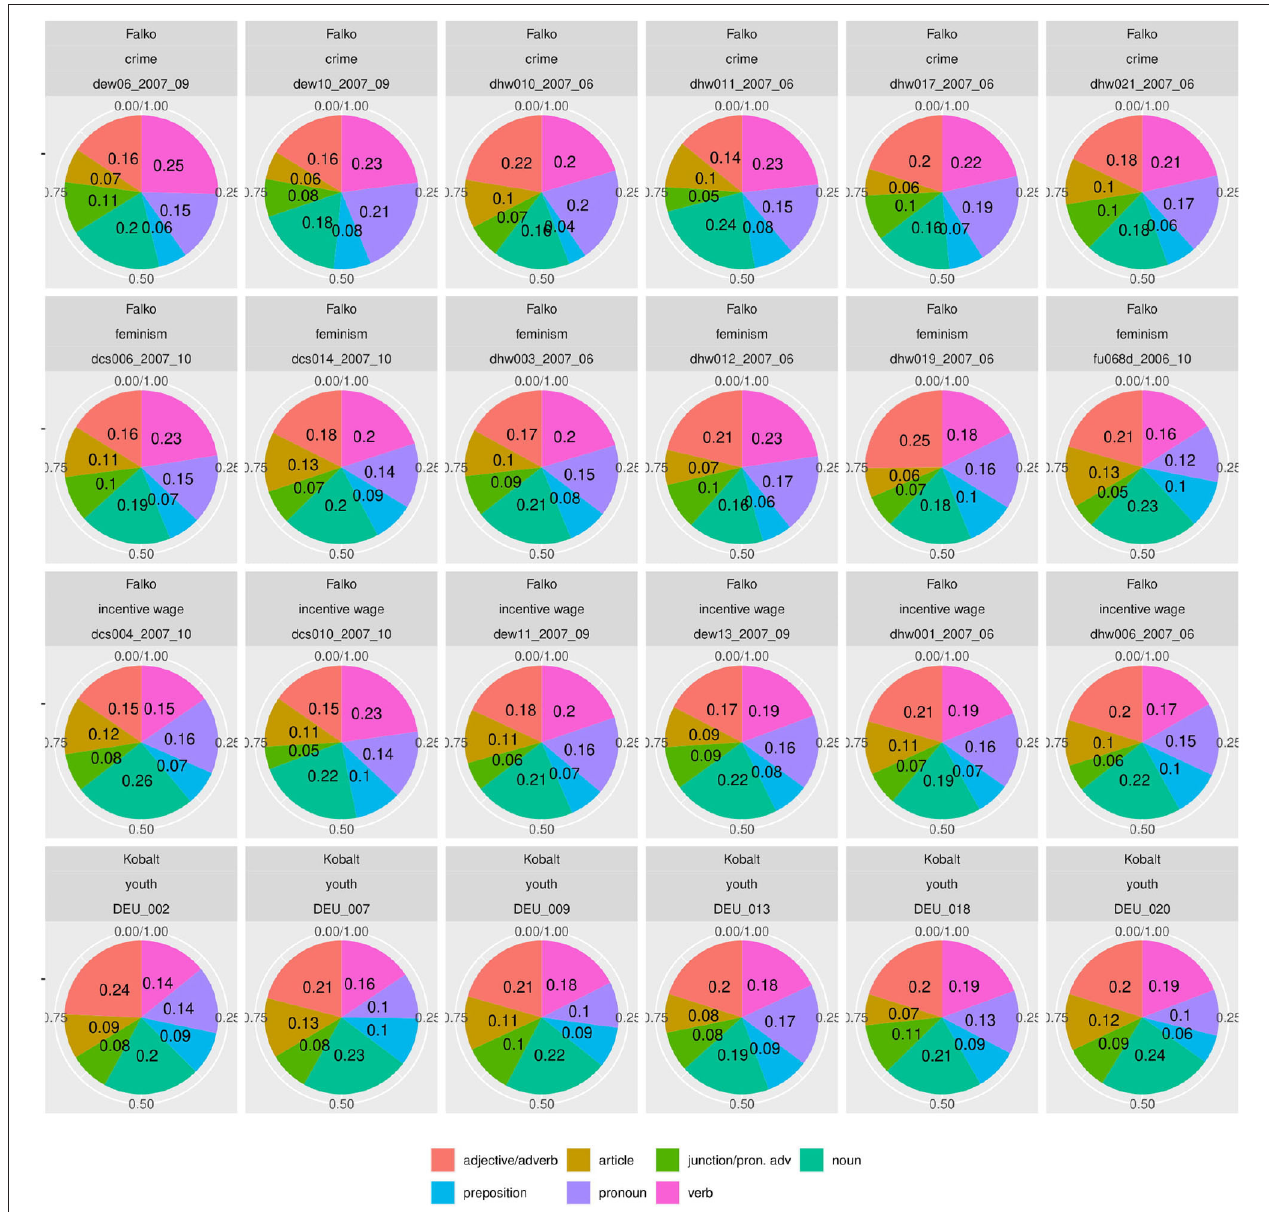
FIGURE 9 | Individual part-of-speech distributions in Falko and Kobalt are much more homogeneous than the morphological, syntactic, and morphosemantic subclasses of verbs and nouns.